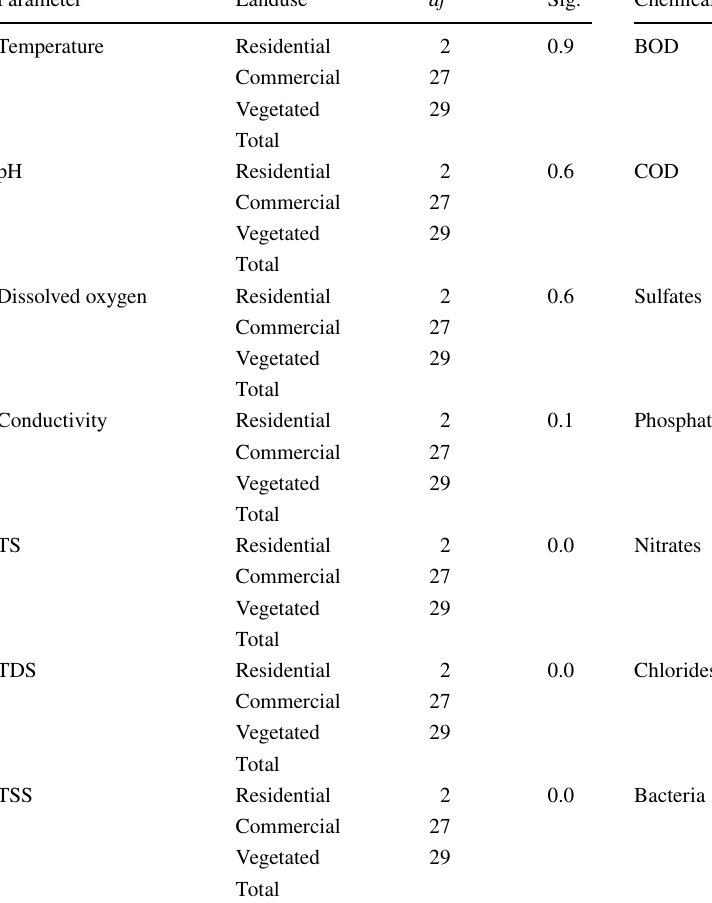
Table 3 Variation in the physical parameters of surface water along the landuse types Parameter